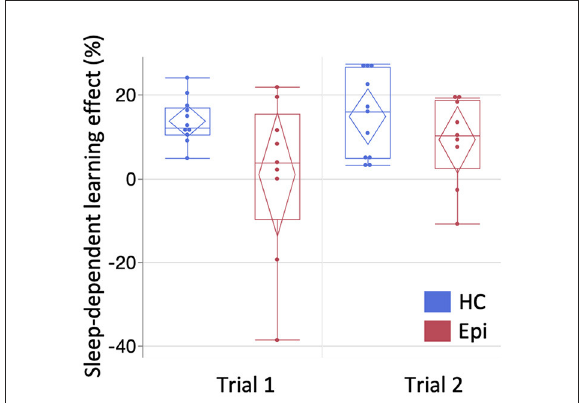
FIGURE4 The comparison of sleep-dependent learning effect between groups. The mean sleep-dependent learning effect of the patient group was compared with the healthy group for each trial. Box-and-whisker plot is shown here. Starting from the bottom, each line represents the minimum, lower quartile, median, upper quartile, and maximum. Diamonds indicate the 95% confidence interval of each mean. One-sample t -test compared to zero showed significance in Trials 1 [ t (10) = 8.4, P < 0.0001] and 2 [ t (10) = 5.0, P = 0.0006] of the healthy group and in Trial 2 of the epilepsy group [ t (8) = 2.7, P = 0.026], but not in Trial 1 of the epilepsy group [ t (8) = 0.16, P = 0.87]. HC, healthy controls; Epi, epilepsy patients.